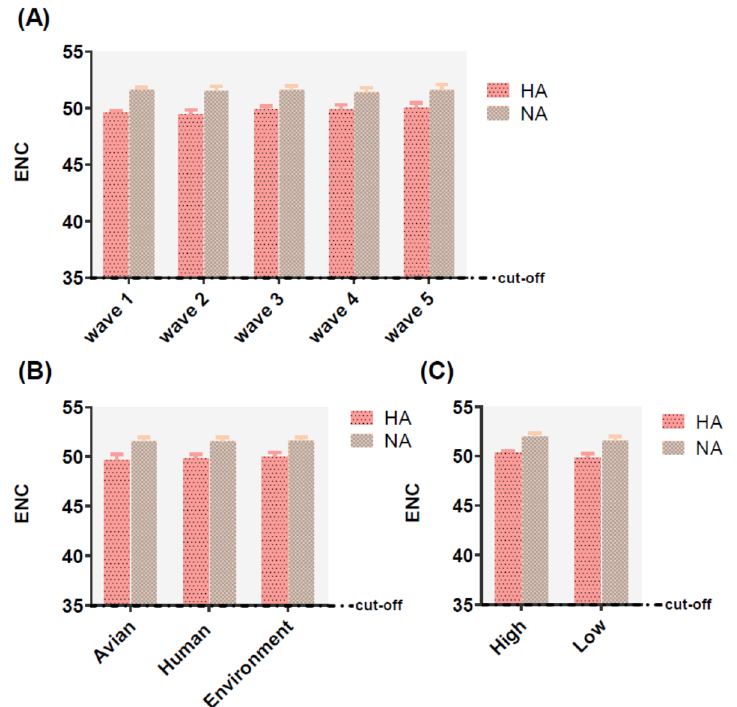
Figure 3. E ff ective number of codon (ENC) analysis of HA (displayed in pink and black dot histogram) Figure 3. Effective number of codon (ENC) analysis of HA (displayed in pink and black dot and NA (displayed in earthy yellow and gray squares histogram) of di ff erent waves ( A ), hosts ( B ), and histogram) and NA (displayed in earthy yellow and gray squares histogram) of different waves ( A ), pathogenicity ( C ). The cut-o ff value of the ENC value is 35. The larger the ENC value, the lower the hosts ( B ), and pathogenicity ( C ). The cut-off value of the ENC value is 35. The larger the ENC value, codon usage the lower the codon usage bias.